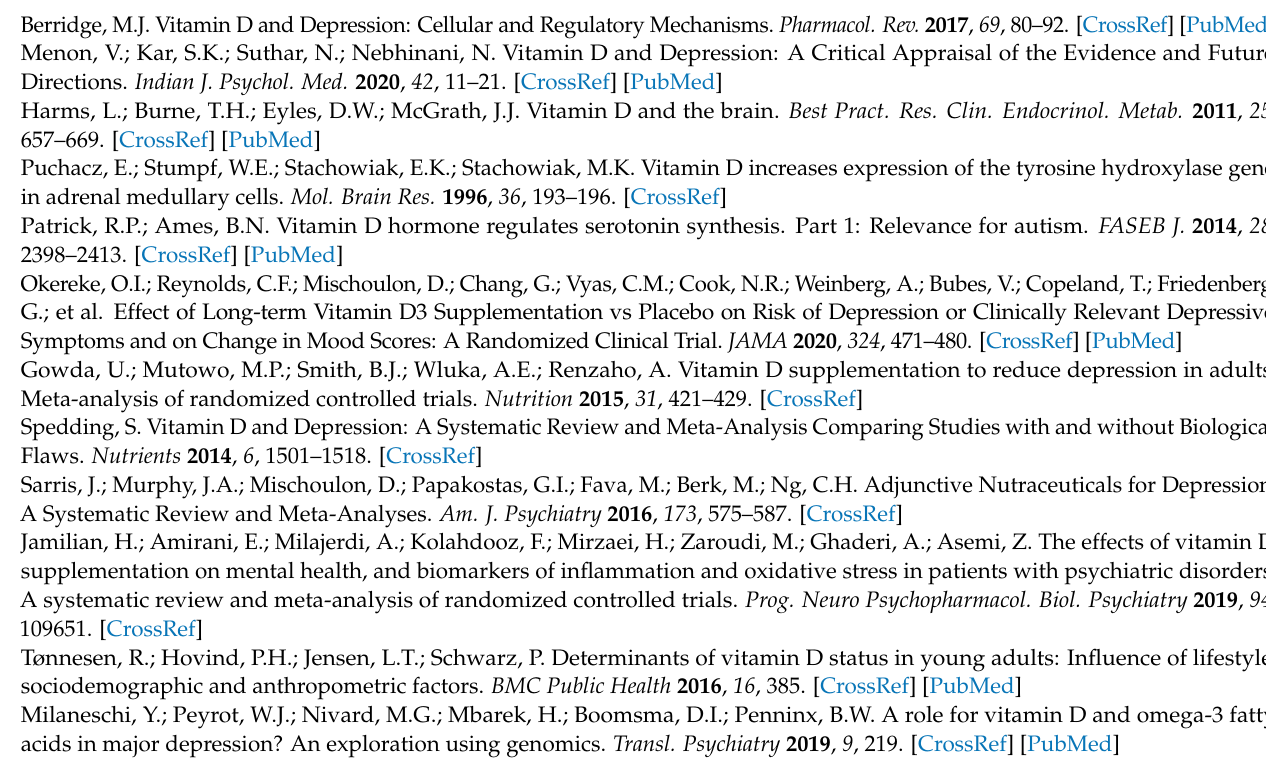
Plots from two-sample MR analysis of 25(OH)D on depression. Plot A shows the Scatter plot of the estimates of variant-depression association against estimates of variant-25(OH)D association. Plot B shows the funnel plots of instrument strength against causal estimate ( β IV). Plot C includes leave-one-out analyses, demonstrating the effect on the overall MR IVW estimate by excluding each of the six variants one at a time. Figure S6. Observational and MR analyses on the association between 25(OH)D (using the 122 25(OH)D-related variants from Revez et al. [26]) and the odds of de- pression. Figure S7. Plots from two-sample MR analysis of depression on 25(OH)D. Plot A shows the scatter plot of the estimates of variant-25(OH)D association against estimates of variant-depression association. Plot B shows the funnel plots of instrument strength against causal estimate ( β IV). Plot C includes leave-one-out analyses, demonstrating the effect on the overall MR IVW estimate by excluding each of the 44 variants one at a time. Figure S8. Two-sample MR estimates from different MR approaches using 17 major depression-related genetic variants from Hyde et al. [29]. MR Egger intercept p -value = 0.87. Figure S9. Percent change in serum 25(OH)D associated with depression (Observational), or genetic liability to depression (MR) using 17 major depression-related genetic variants from Hyde et al.